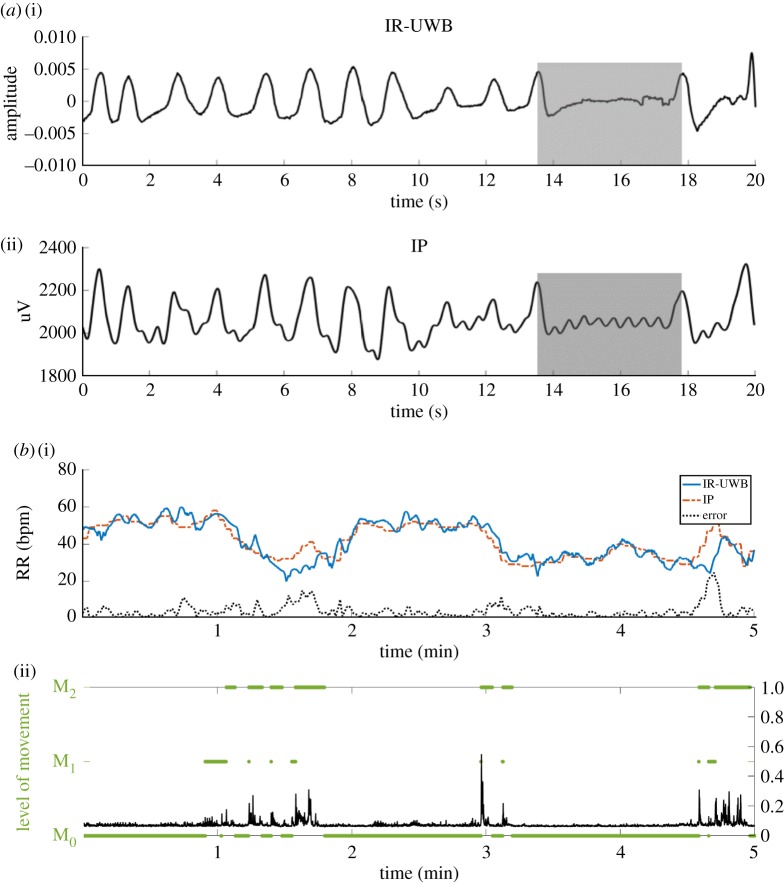
Representative results of the raw signal waveform and estimated RRs from both devices. (a) Relatively regular breathing signal waveforms from the IR-UWB radar (i) and IP (ii). Short periods of breathing cessation (shaded box), such as apnea or periodic breathing, were comparably detected by IR-UWB radar and IP. (b) Measured RRs from the IR-UWB radar system and IP in a 5 min section (M0-dominant). Panels (i) show RR estimates derived from the IR-UWB radar system in blue and the IP-derived estimates in red. Panels (ii) show the level of movement calculated by the IR-UWB radar system. Real movement traces are shown by black waves, and the movements classified into levels are shown with green bars. M0, the segment of no body movement; M1, small movements; M2, larger movements; IP, impedance pneumography; bpm, breaths per minute.